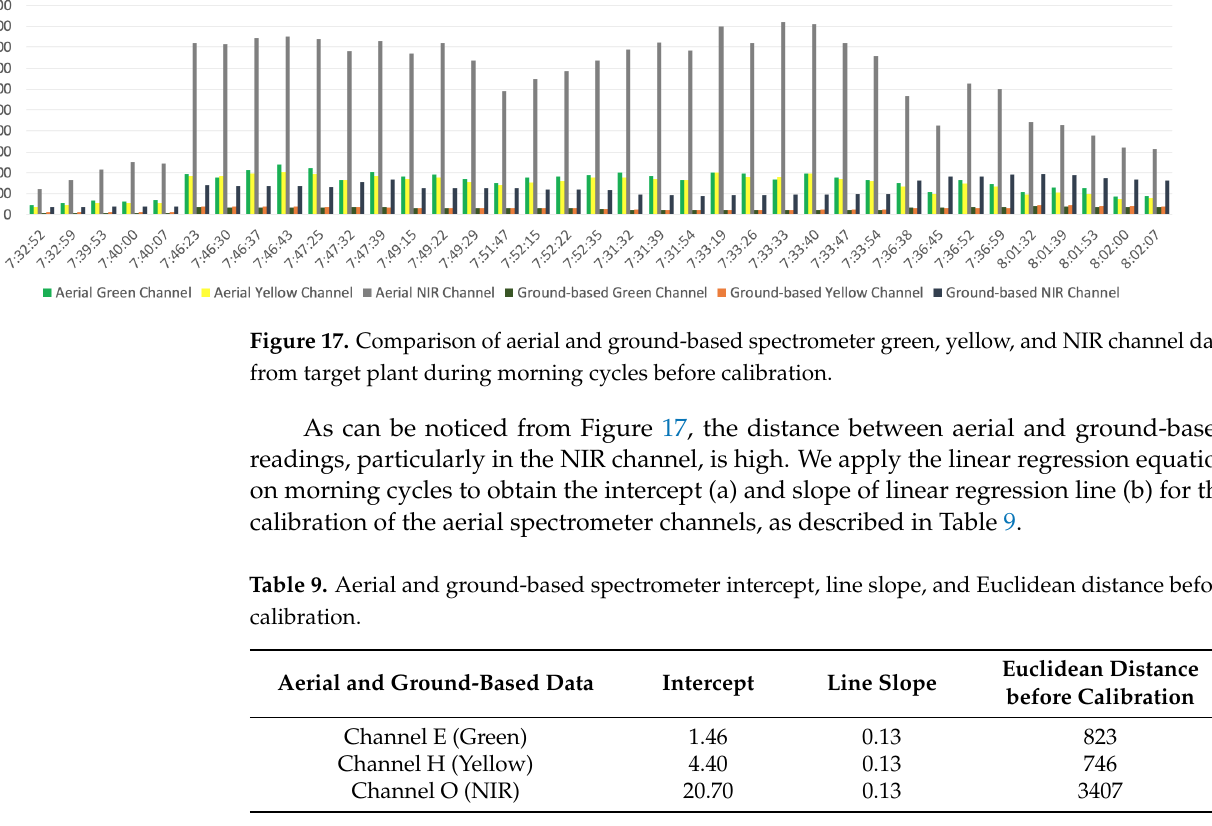
Figure 16. Comparison of aerial and ground-based spectrometer green, yellow, and NIR channel data from target plant.